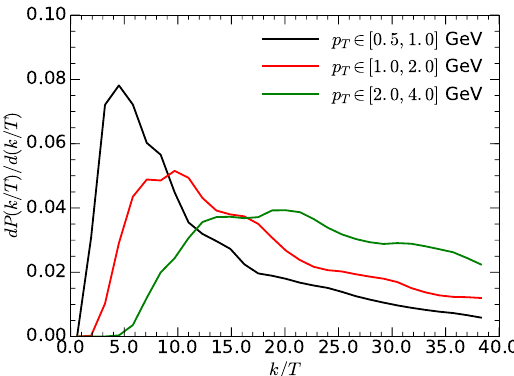
Figure 12 . The probability distribution of the values of k=T at which the QGP rates were evalu- ated in a typical 0{40% Pb+Pb collisions at 2.76 TeV. The three curves represent the probability distributions in three di(cid:11)erent photon transverse momentum ( p T ) ranges in the lab frame.